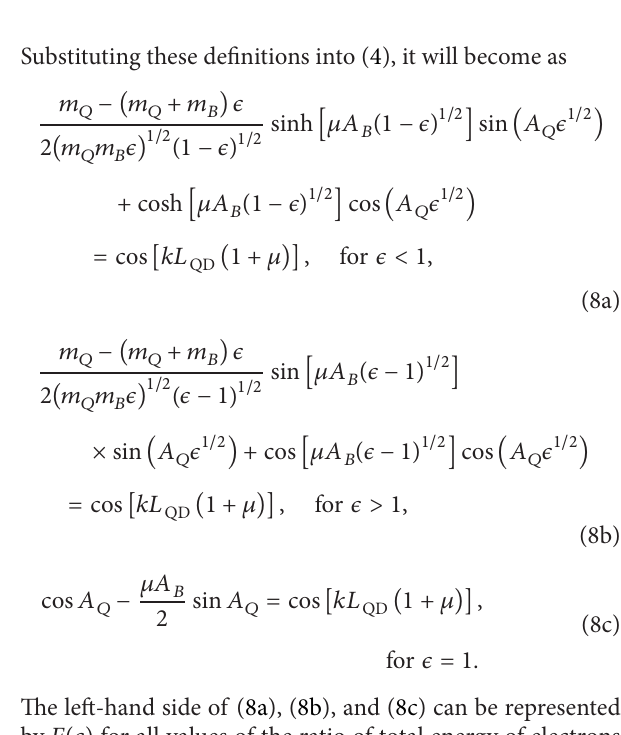
Figure 1: Minibands formation in the superlattice structure and Kronig-Penney